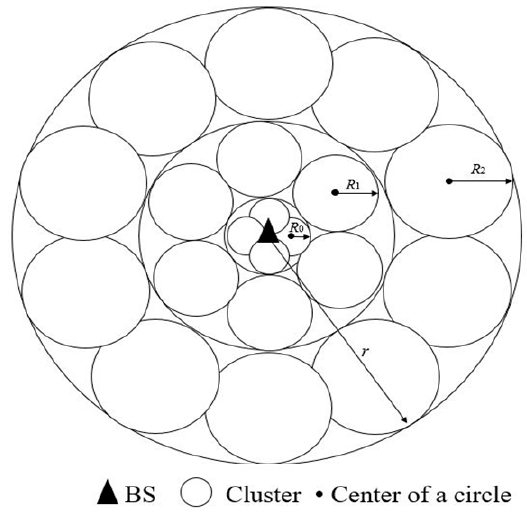
Figure 3. Uniform distribution by layer of circular areas.